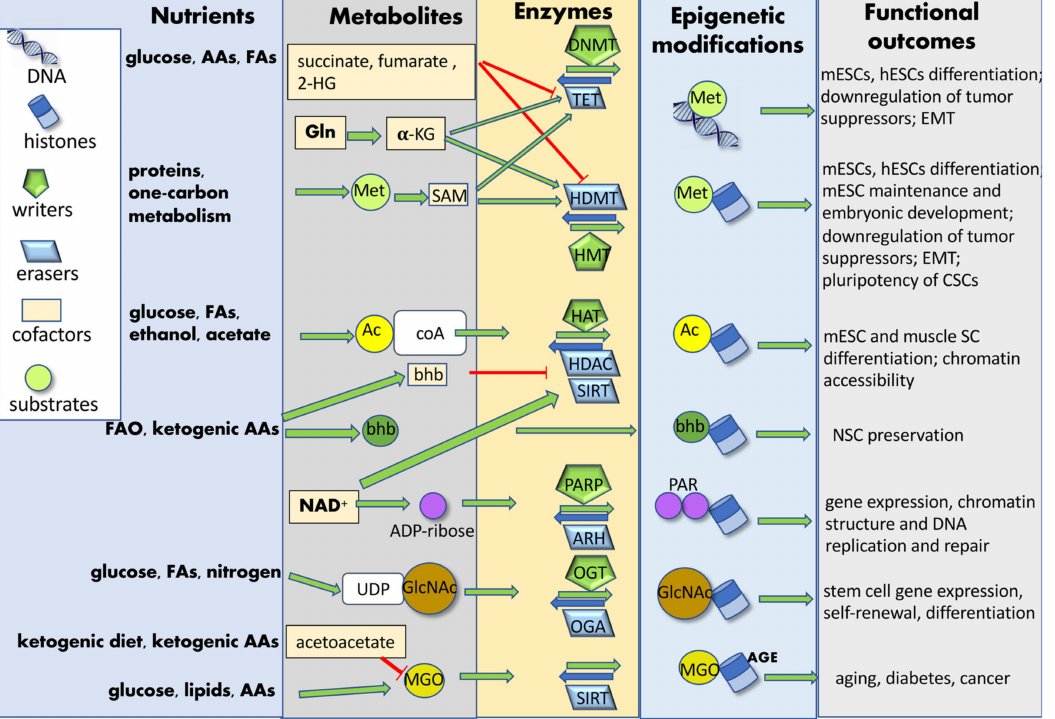
Figure 3. Nutrient-induced epigenetic modifications. Nutrients introduced by diet are processed into simple metabolites and further catabolized by SC metabolic enzymes into substrates or cofactors utilized by chromatin-modifying enzymes. Nutrient-induced epigenetic modifications may affect both histones and DNA, either enzymatically or non-enzymatically. Metabolites can function as co-factors or substrates for enzyme catalyzing either the addition (“writers”) or the removal (“erasers”) of tagging groups. These chromatin modifications finally affect SC gene expression and fate determination. Abbreviations: